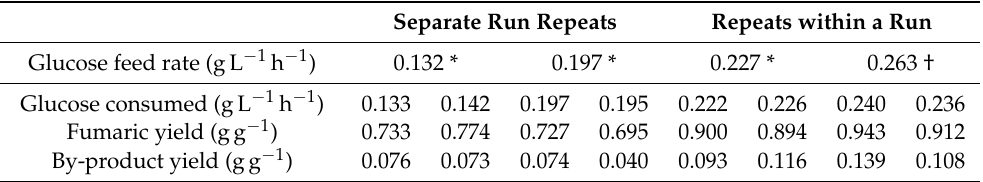
Table 1. Repeatability and stability of fumaric acid production evaluated through glucose consump- tion and